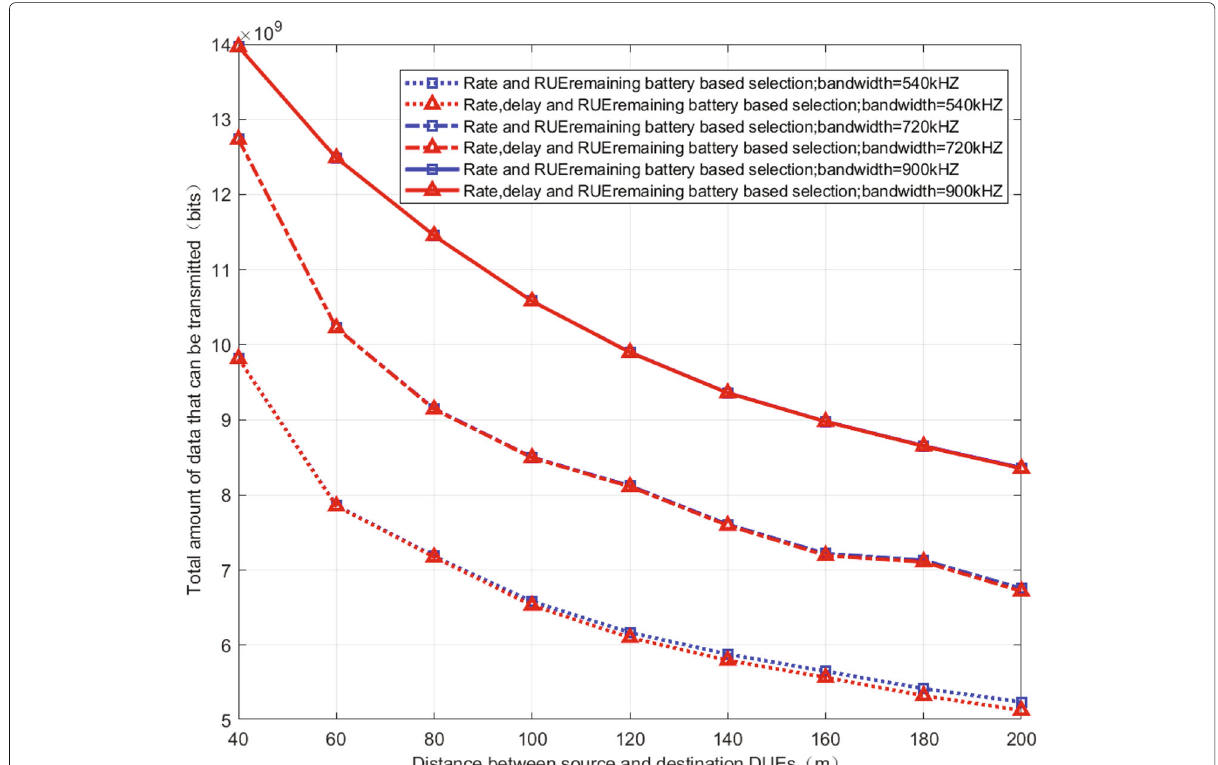
Fig. 8 The total transmitted data in different bandwidths for joint network coding and relay selection